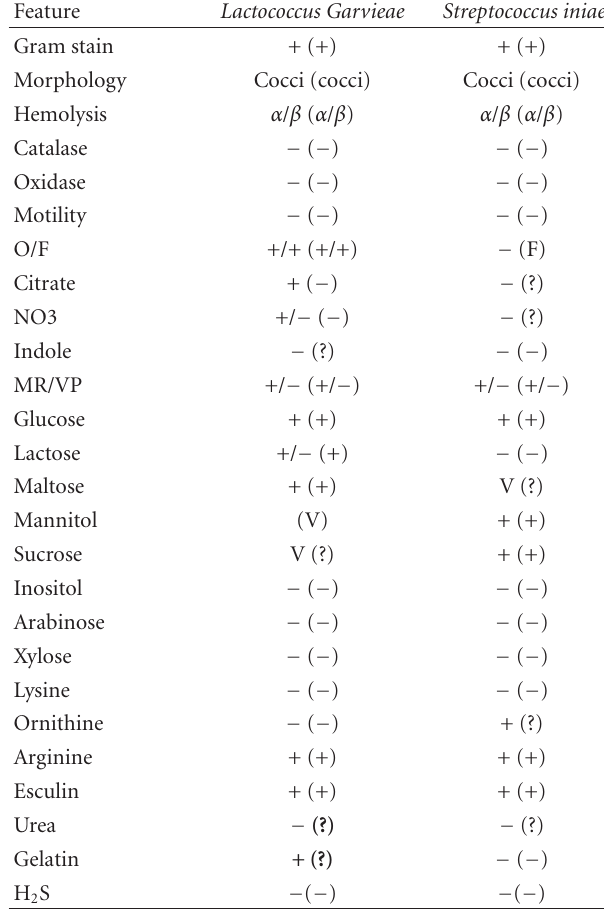
Table 2: Random primers used for RAPD analysis using 35 ◦ C as the annealing temperature. Primer sequence